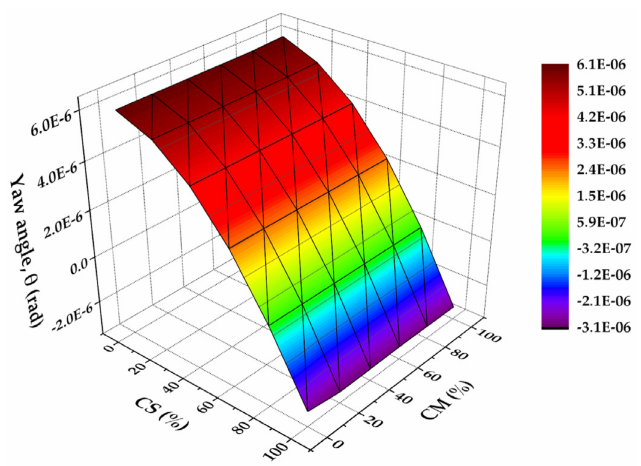
Figure 18. Convergence yaw angle ( θ ) vs. CM and CS .